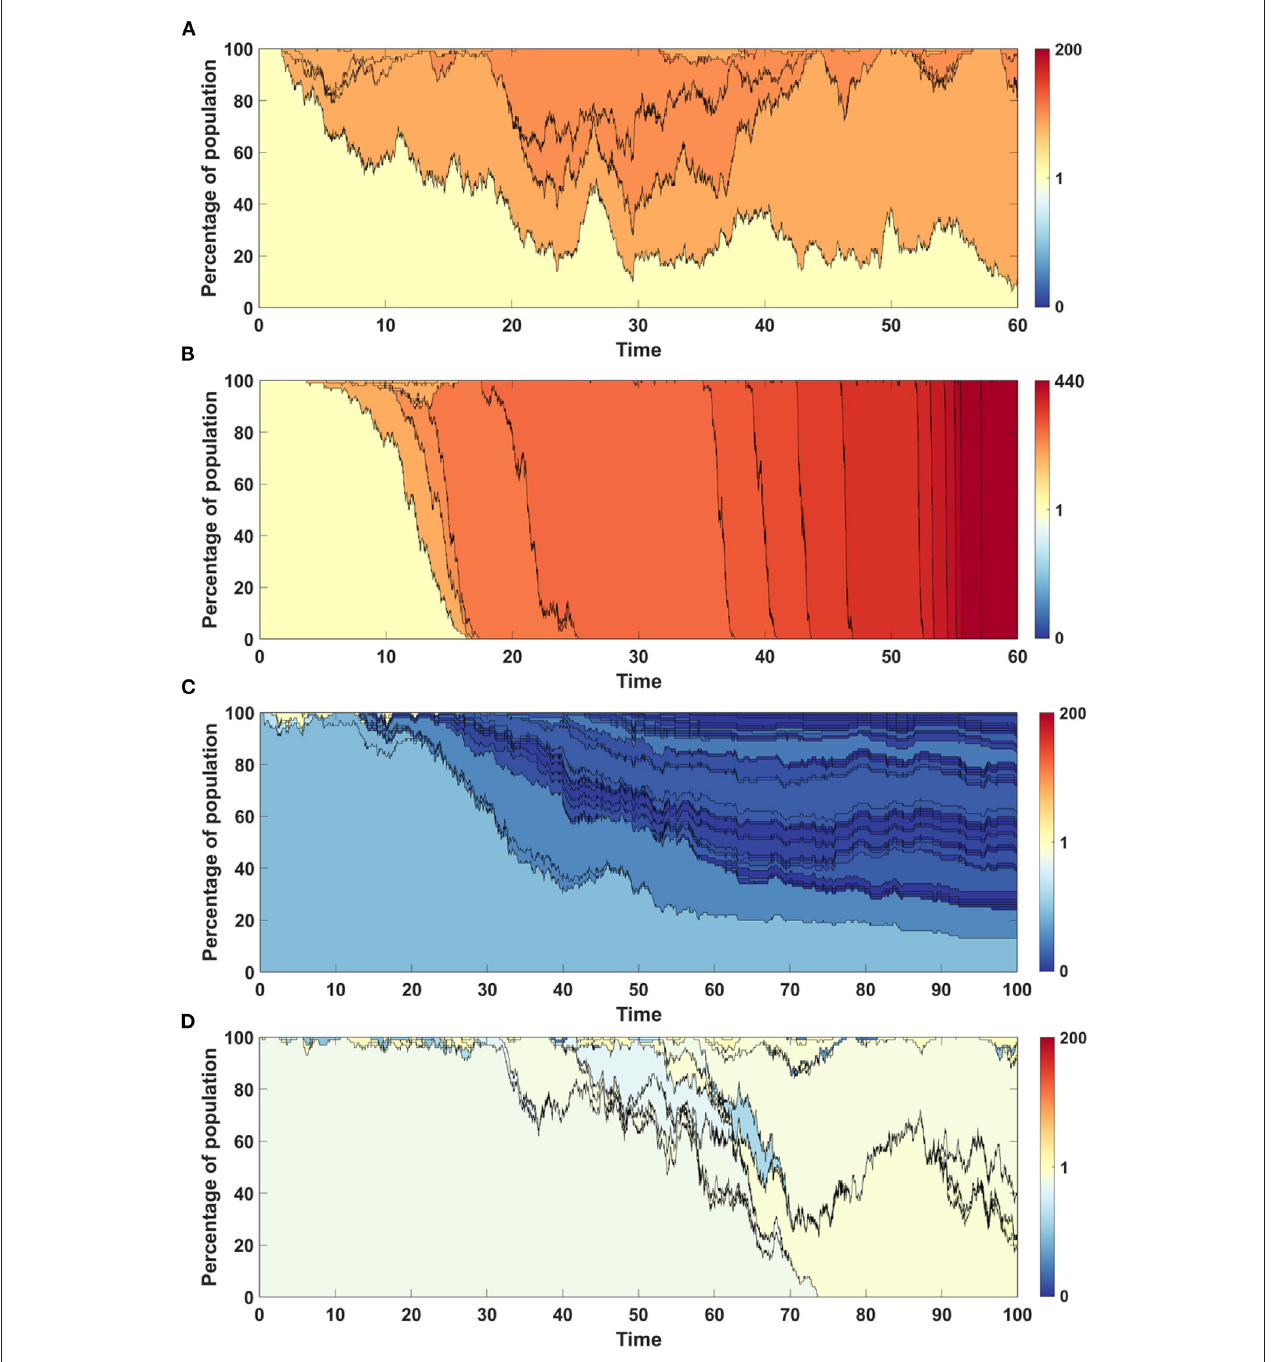
FIGURE 10 | Time succession patterns. Clones started with driver mutations are colored according to average fitness of given clone. (A,B) Results of one simulation on N = 100 cells with parameters: s = 0.5, d = 0, µ = 0.1, p = 0.1 ( sp > dq ). (A) Model A; (B) Model B. (C,D) Results of one simulation on N = 100 cells with parameters: s = 0, d = 0.5, µ = 0.1, p = 0.1 ( sp < dq ). (A) Model A; (B) Model